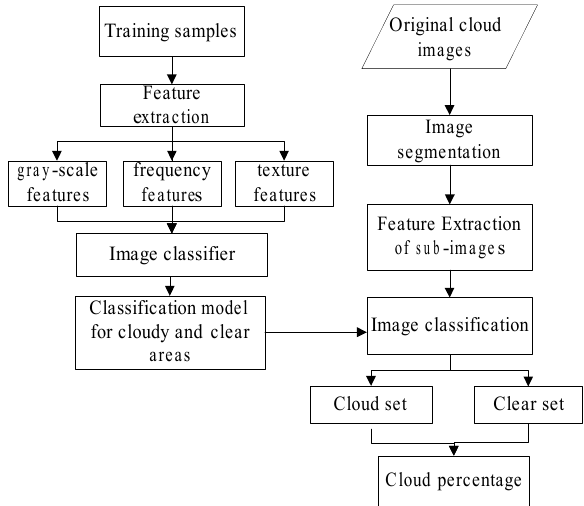
Figure 2. Workflow of the cloud detection method based on feature extraction in remote sensing